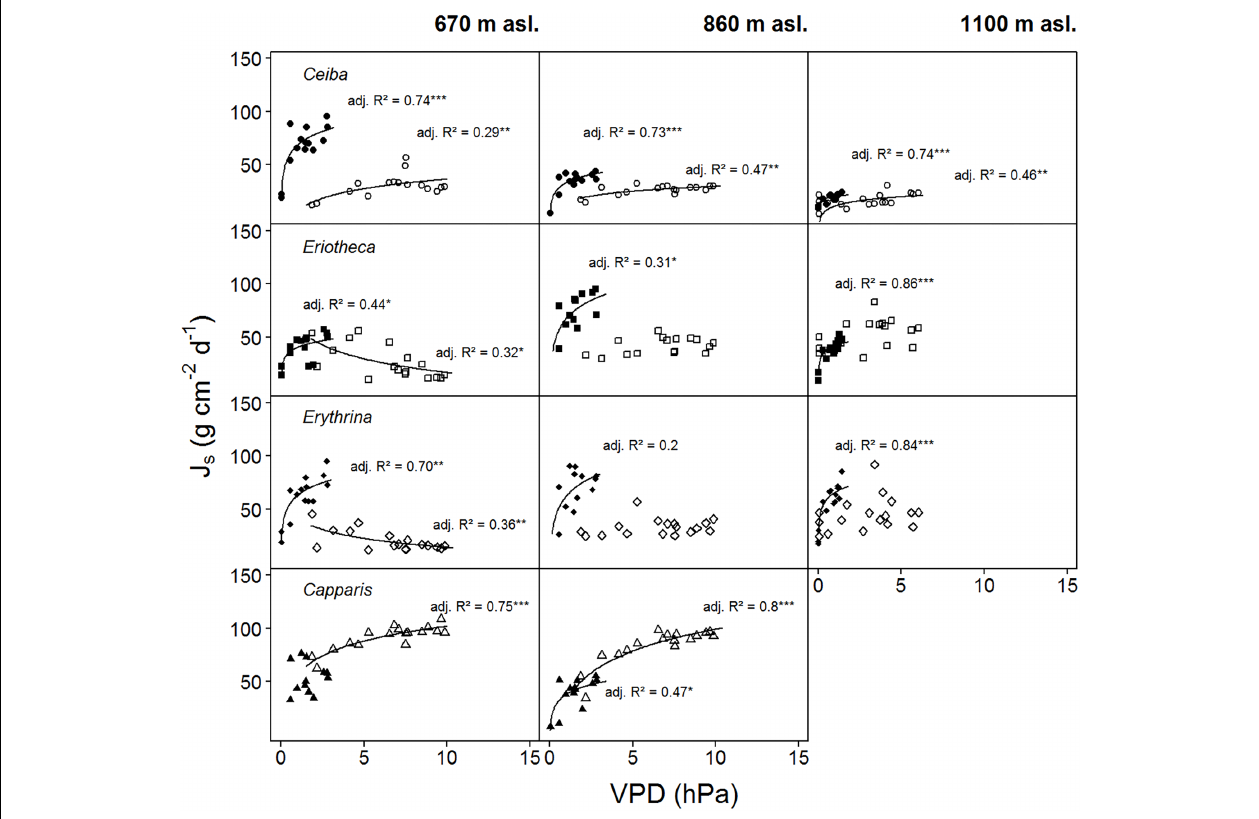
FIGURE 5 | Daily sap flux densities (Js) of the four study species plotted against average daily VPD. Filled symbols indicate wet conditions (SWC > 25%), open symbols dry conditions (SWC < 15%) (data from two weeks per period). Logarithmic regressions were fitted to the data: p < 0.0001 ‘ ∗∗∗ ’, p < 0.001 ‘ ∗∗ ’, p < 0.01 ‘ ∗ ’, p < 0.5 ‘.’, p < 0.1 ‘ ’, R 2 is given in italics. Daily sap flux densities derived from measurements of n = four individuals per species per altitude and